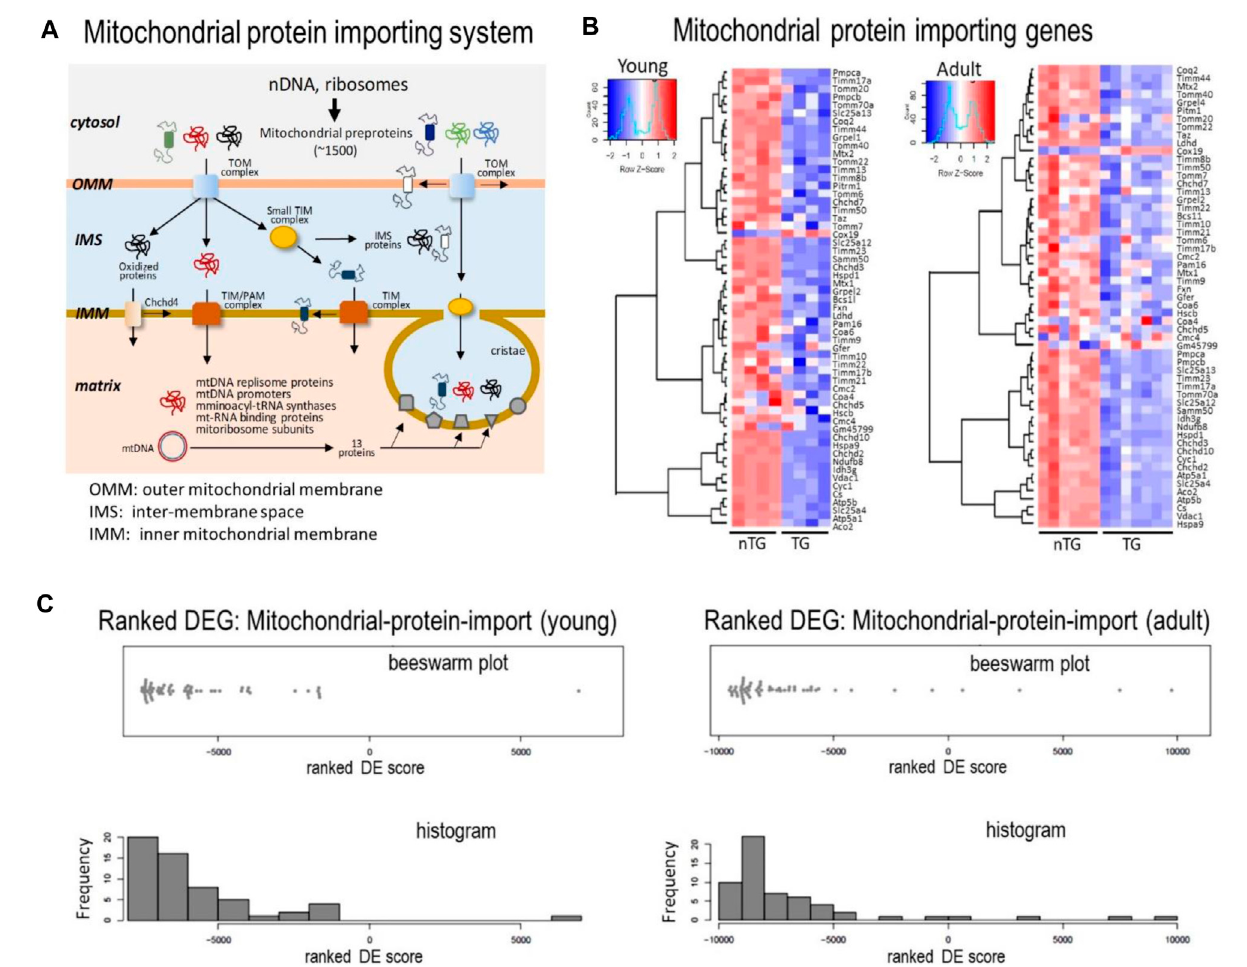
FIGURE 7 | Expression levels of genes for the mitochondrial protein importing machinery. (A) Cartoon depicting the mitochondrial protein-importing machinery consisting of TOM and TIM complexes. Highlighted is the transportation via the machinery of multiple sets of proteins indispensable for mtDNA transcription and translation. Heatmaps (B) and Beeswarm plots and histogram (C) showing suppressed expression of genes coding proteins of the mitochondrial protein-importing machinery in DCM hearts from young and adult mice.